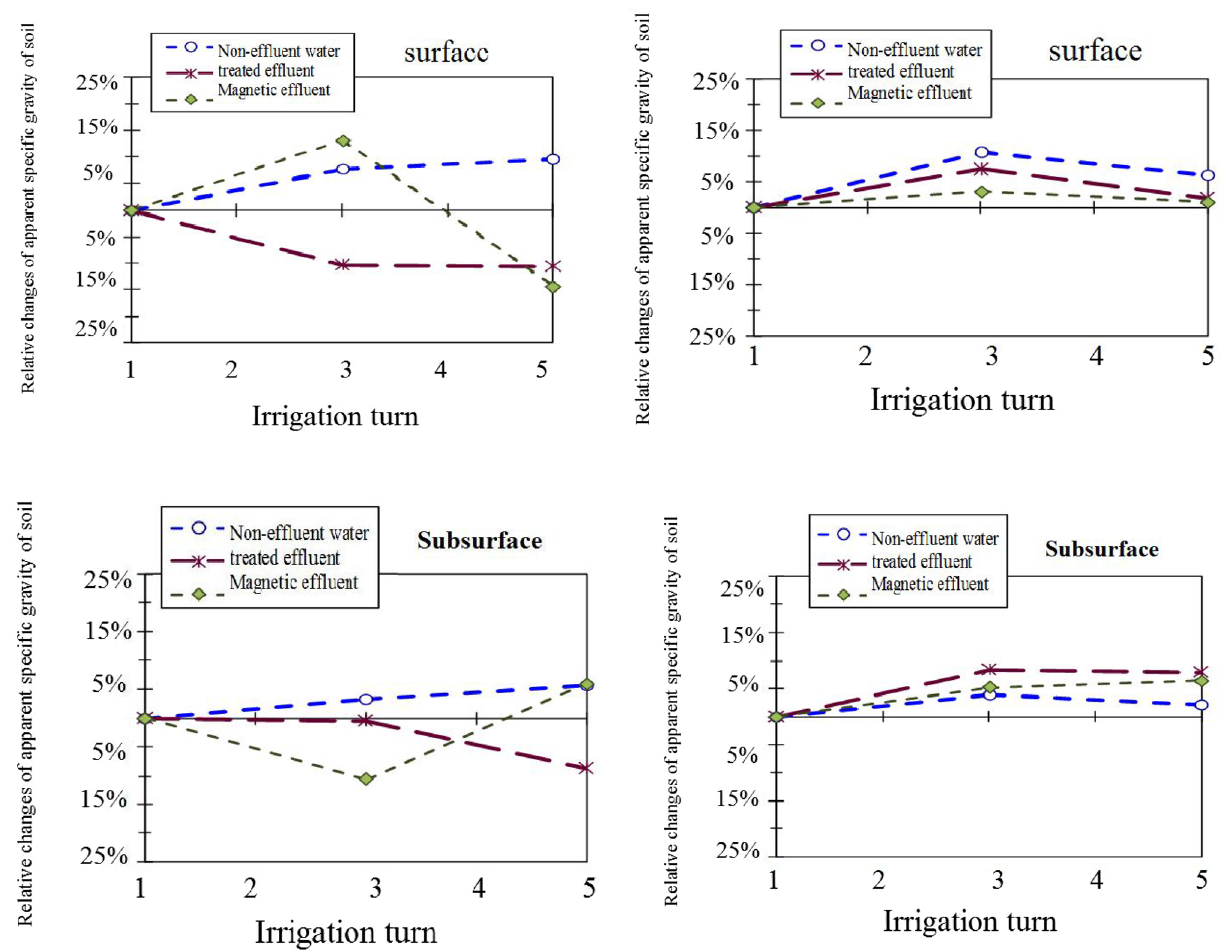
Fig. 1 Relative changes in apparent density of soil during the irrigation period, in two soil layers, and at the beginning (left) and end of furrow (right) Table 3 The result of statistical analysis of random block design related to "changes in soil specific